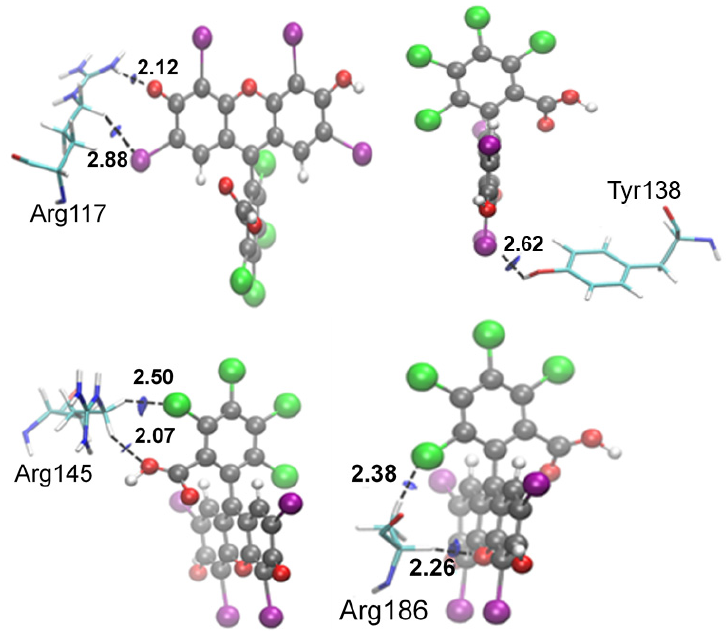
Figure 7. Interactions of RB dye to HSA DS3 obtained in NCIplot studies and analyzed by VMD software.